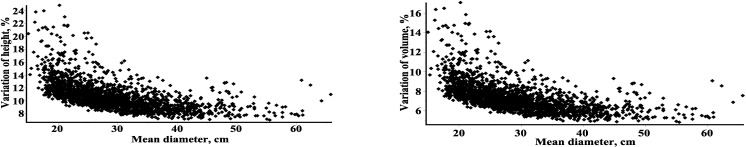
Coefficient of variation of tree height and volume for plots within estimation dataset.Left–tree height; right–stem volume.